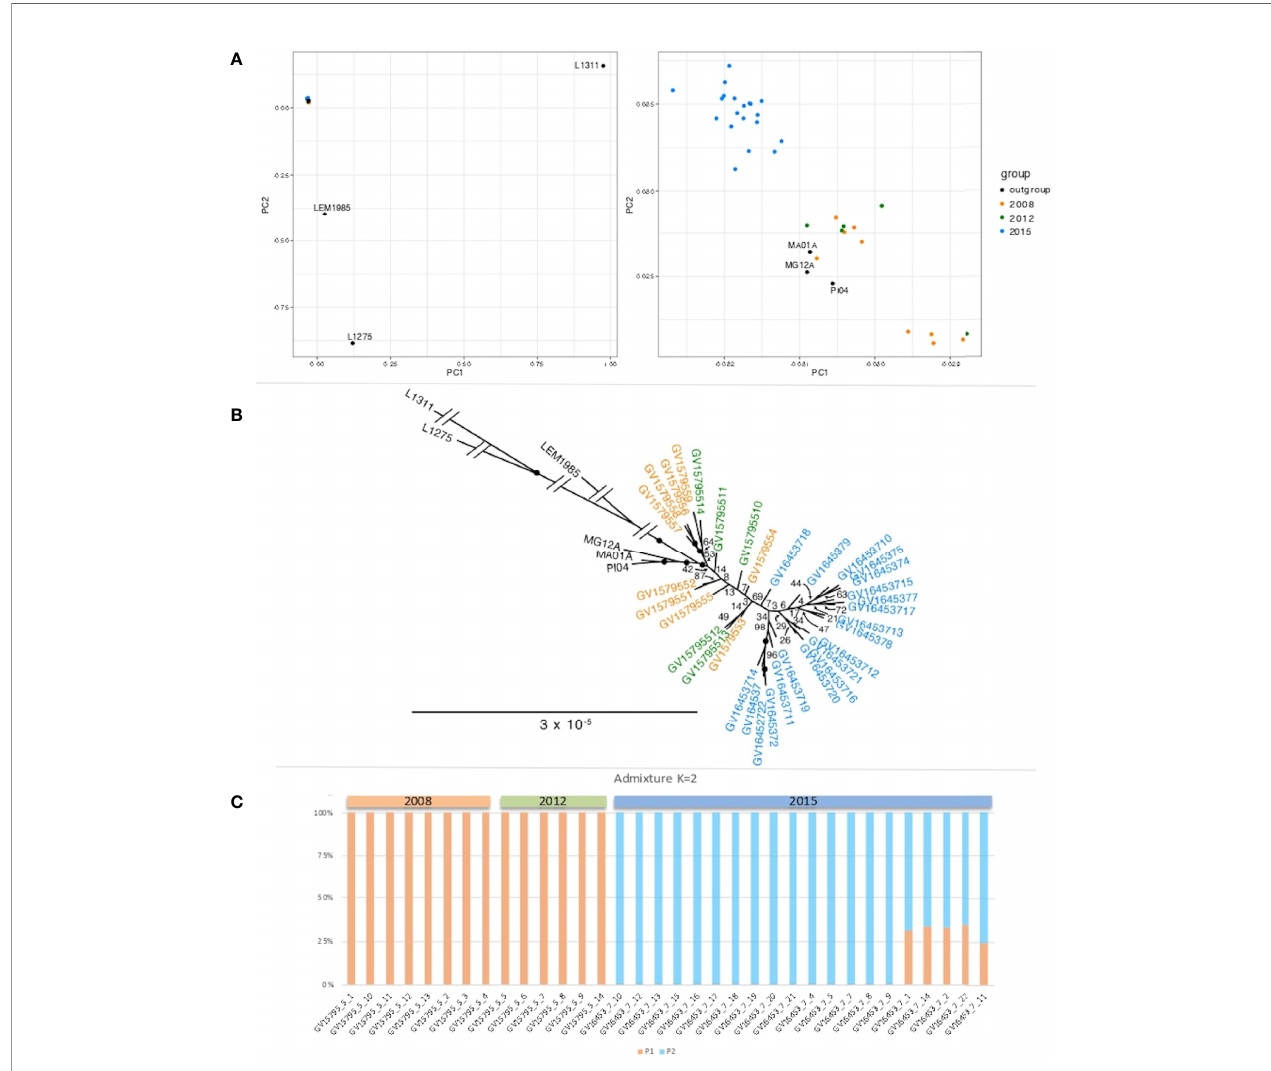
FIGURE 2 | Genomic relationship between Governador Valadares L. (L.) infantum isolates. (A) Principal component analysis (PCA) based on genome-wide SNP variations. Left panel includes Brazilian and Old World isolates (Israel: LRC-L1275, France: LEM1985 and Uzbekistan: LRC-L1311. Right panel is a zoom-in of the left panel showing only the Brazilian isolates (colored dots are Governador Valadares isolates and black dots are isolates from other Brazilian regions: MG12A, Montes Claros from Minas Gerais state; MA01A, Paraibano from Maranhão state and PI04, Valenc ̧ a from Piau ı ́ state. The fi rst two PCA axes represent 53.12% and 13.58% of the variance, for a total of 66.7%. (B) Maximum likelihood phylogenetic tree showing two Governador Valadares isolate clades. (C) Population structure results con fi rming the presence of two distinct L. (L.) infantum subpopulations in the city of Governador Valadares, orange bars represent ancestral population 1, whereas blue bars represent population